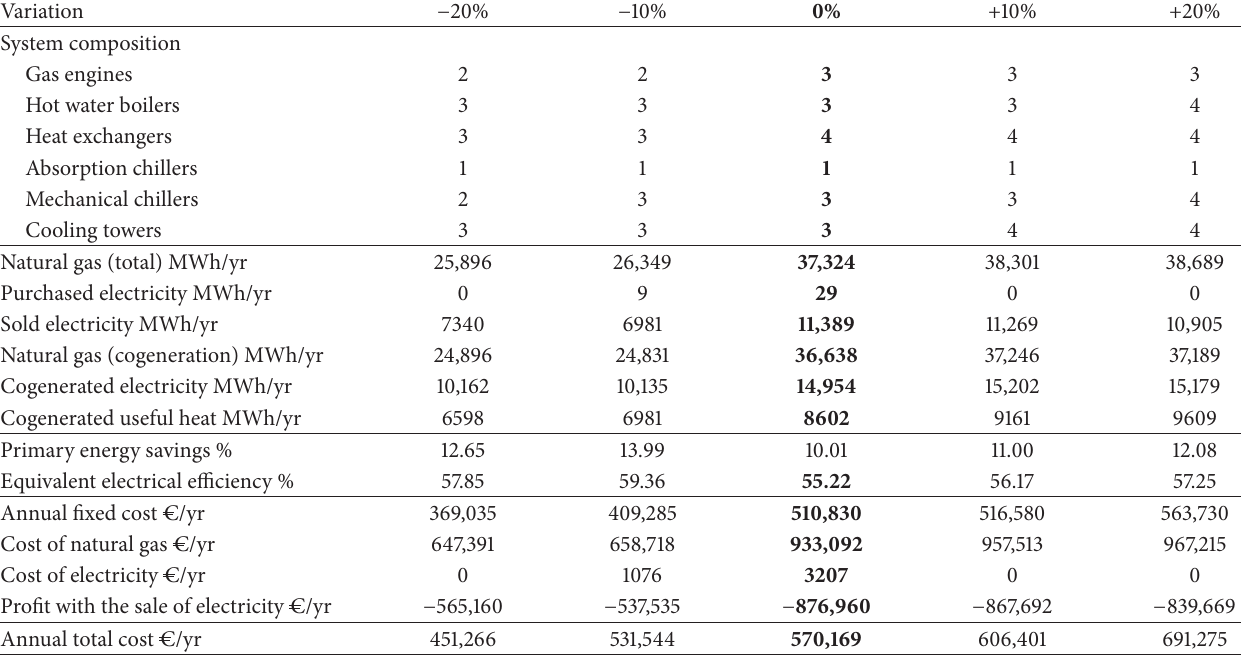
Table 3: Sensitivity analysis for a variation in energy